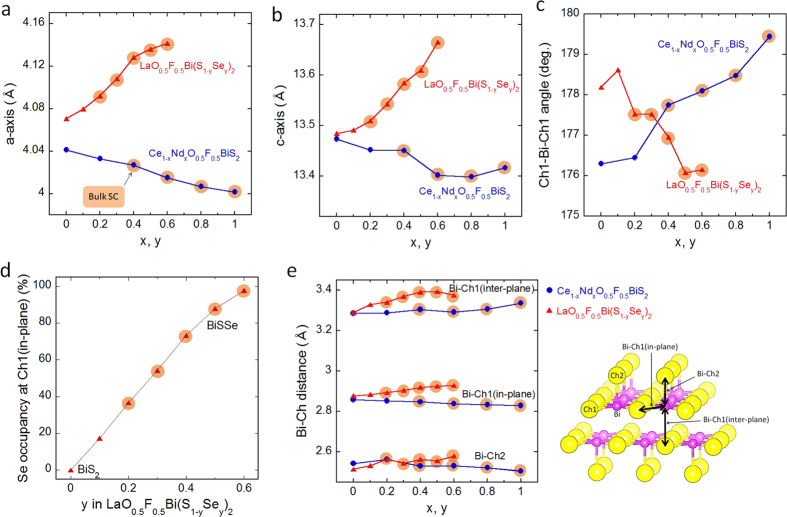
Crystal structure parameters for Ce1−xNdxO0.5F0.5BiS2 and LaO0.5F0.5Bi(S1−ySey)2.(a) Lattice constant of a for Ce1−xNdxO0.5F0.5BiS2 and LaO0.5F0.5Bi(S1−ySey)2 is plotted as a function of x (or y). Data points for the samples showing Bulk SC in Fig. 1 are highlighted with orange filled circles in (a–e). (b) Lattice constant of c for Ce1−xNdxO0.5F0.5BiS2 and LaO0.5F0.5Bi(S1−ySey)2 is plotted as a function of x (or y). (c) Evolution of Ch1-Bi-Ch1 angle for Ce1−xNdxO0.5F0.5BiS2 and LaO0.5F0.5Bi(S1−ySey)2 as a function of x (or y). (d) Se occupancy at the in-plane Ch1 site in LaO0.5F0.5Bi(S1−ySey)2 as a function y. (e) Evolution of three different Bi-Ch distances in Ce1−xNdxO0.5F0.5BiS2 and LaO0.5F0.5Bi(S1−ySey)2 as a function of x (or y). The right image describes the Bi, Ch1 and Ch2 sites, and three Bi-Ch distances: Bi-Ch1 (in-plane), Bi-Ch1 (inter-plane), and Bi-Ch2.